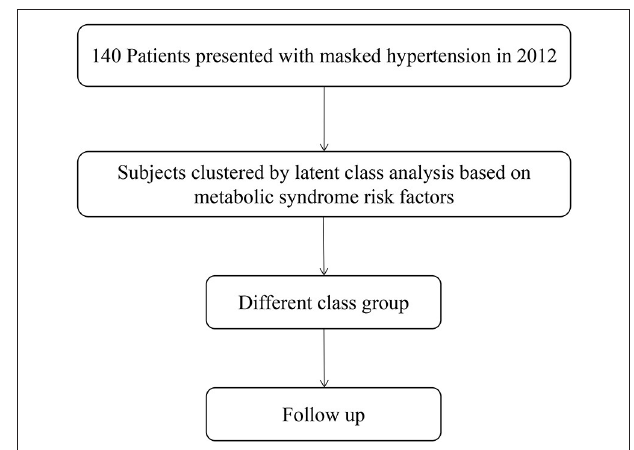
FIGURE 1 | Flowchart of patient enrollment and